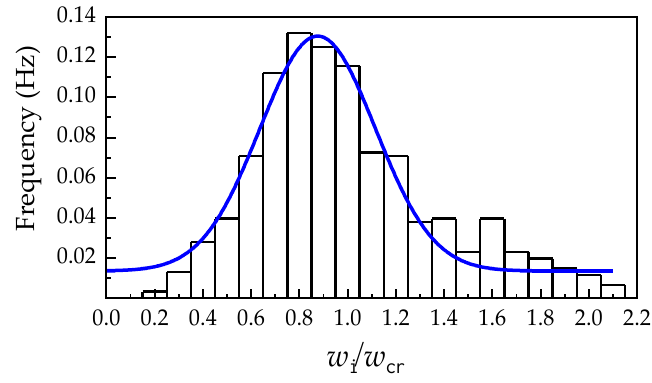
Figure 5 . Probability distribution histogram of w i / w cr. Figure 5. Probability distribution histogram of w